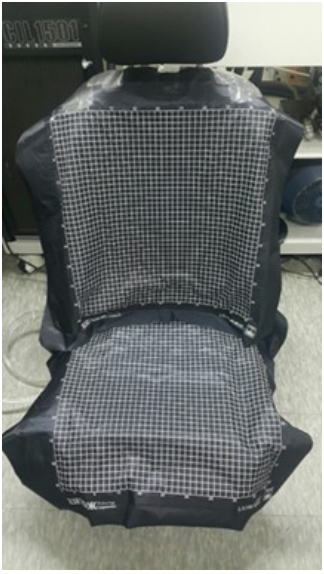
Figure 14. Pressure mat setting with SSA seats.